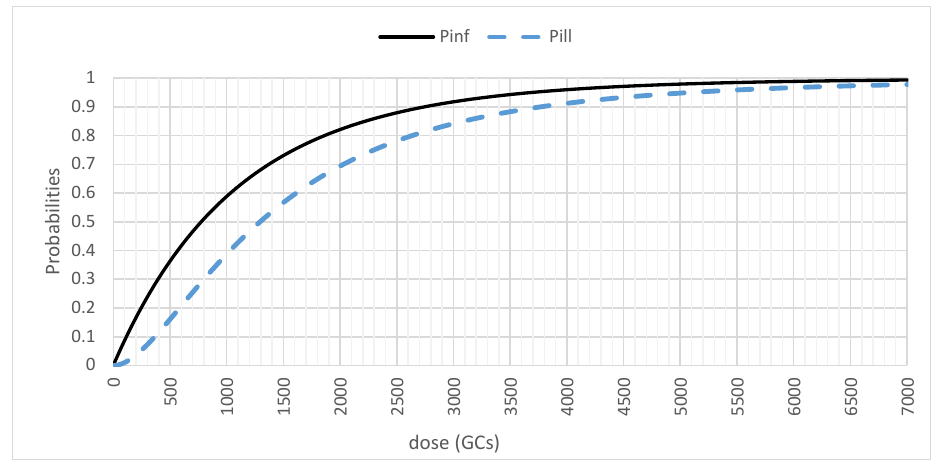
Figure 1. Infection ( P inf ) and illness ( P ill ) probabilities (on a linear scale) as a function of the dose in genomic copies (GCs).